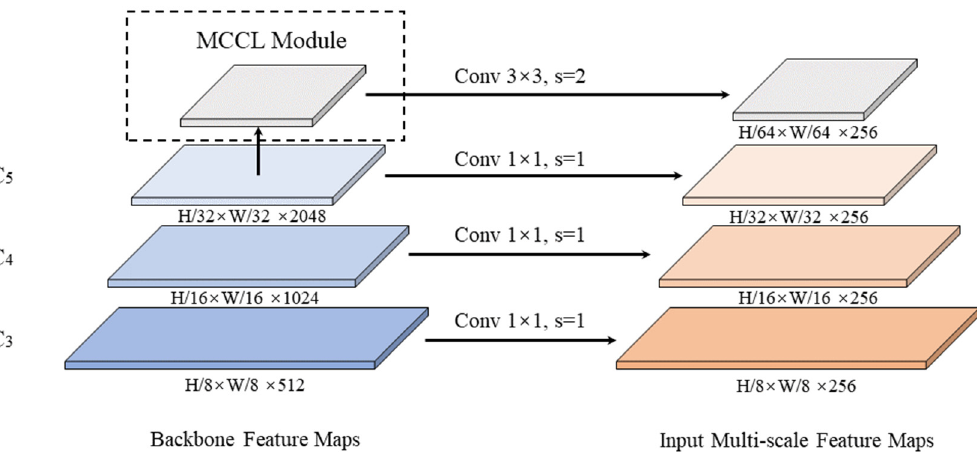
Figure 4. Illustration of the Dense Pyramid Pooling Module.